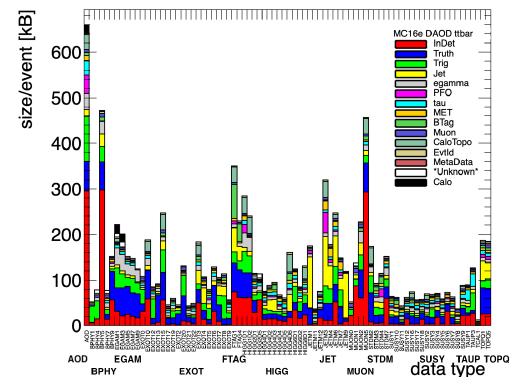
Figure 2. Distribution of size / event for AOD and DAOD formats for a t ¯ t MC sample.